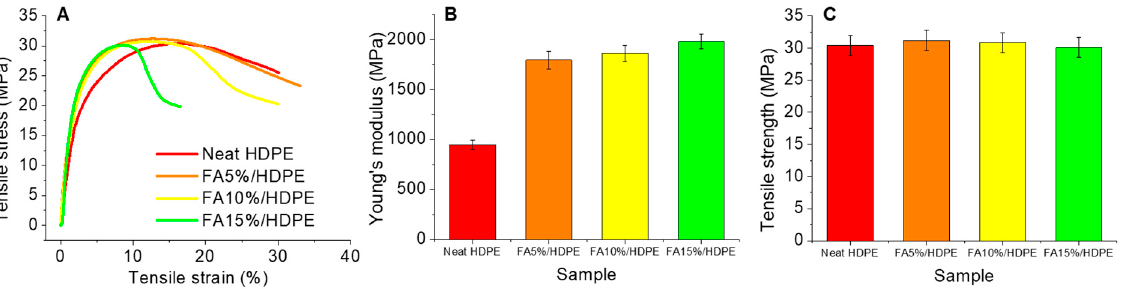
Figure 5. Tensile properties of neat HDPE and FA/HDPE samples: ( A ) representative stress-strain curves, ( B ) comparative Young’s modulus, ( C ) comparative tensile strength.